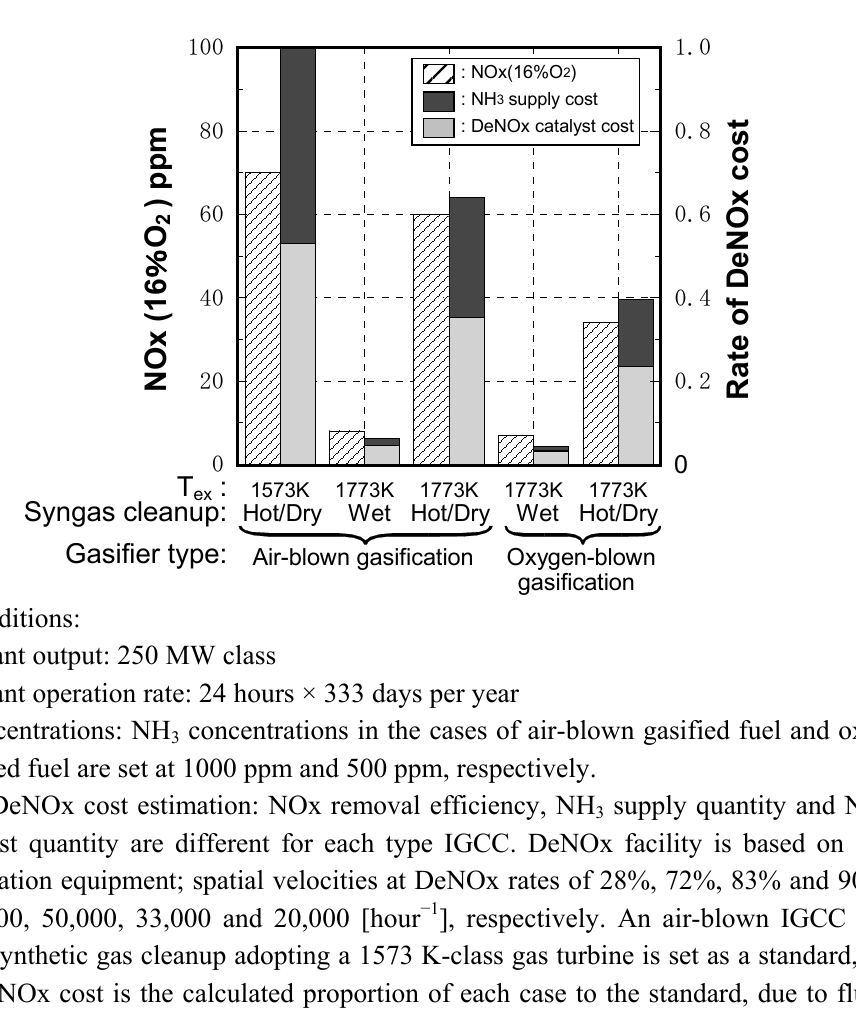
Figure 88. NOx emissions and rates of denitrification costs in various types of